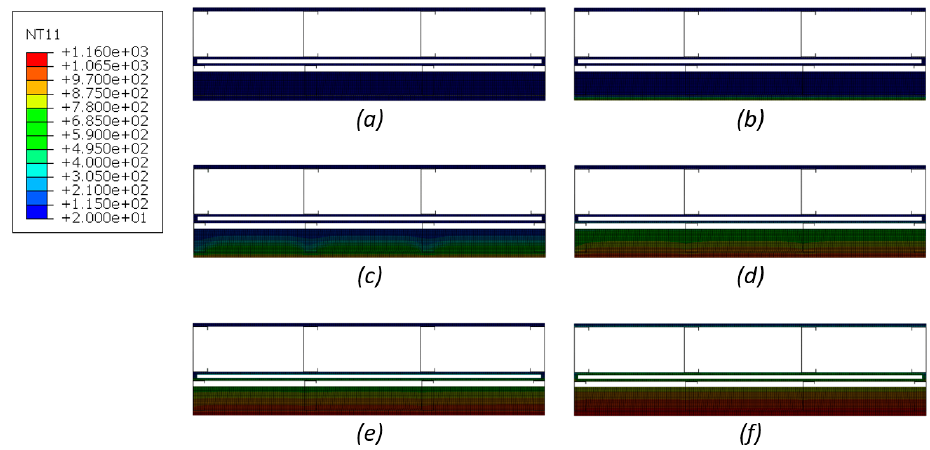
Figure 8. Temperature contours on M_DP_120RW floor specimen cross-section at ( a ) 0 min; ( b ) 30 min;